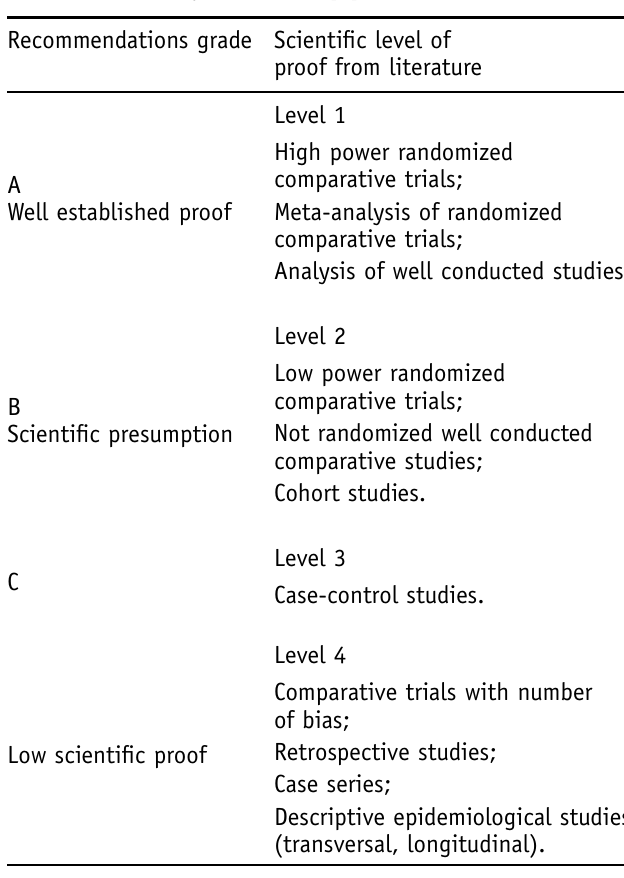
Table 2. Recommendation grades and scienti fi c level of evidence according to the HAS